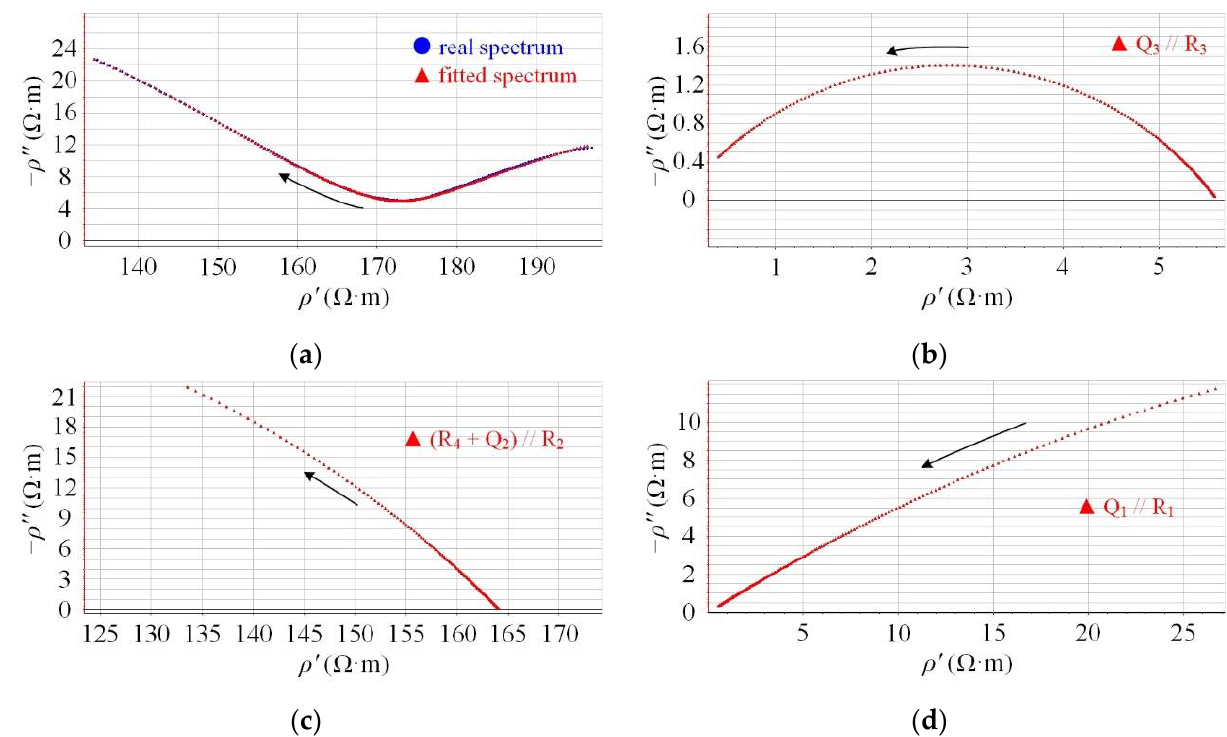
Figure 4. Nyquist plots for the measured resistivity of a typical substrate sample, the corresponding equivalent circuit and its three parts. ( a ) Fitted spectrum well matched with the real (or measured) spectrum; ( b ) Q 3 // R 3 ; ( c ) (R 4 + Q 2 ) // R 2 ; ( d ) Q 1 // R 1 . The substrate is at the volumetric water content of 0.190 cm 3 /cm 3 and dry density of 0.397 g/cm 3 . The frequency range is from 20 Hz to 2 MHz, and the direction of an arrow indicates that of frequency increase. As shown in Figure 2, Q 3 // R 3 , (R 4 + Q 2 ) // R 2 and Q 1 // R 1 denote the resistive effects inside substrate grains, related to the substrate pore network and at the substrate–electrode interface, respectively.